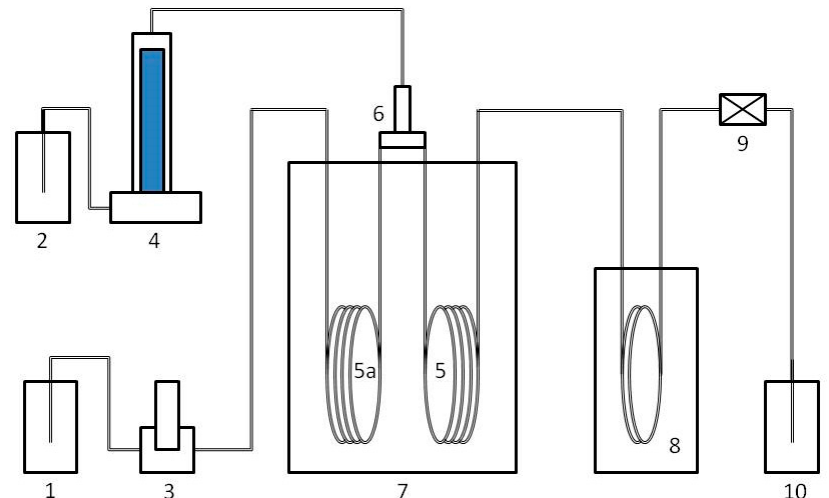
Figure 1. Scheme of the setup with flow reactor for synthesis in supercritical media. (1) Container with alcohol, (2) container with a solution of metal salts, (3) plunger pump, (4) syringe pump, (5) reactor, (5a) alcohol preheating element, (6) mixer, (7) oven, (8) heat exchanger, (9) back pressure valve, and (10) storage container.